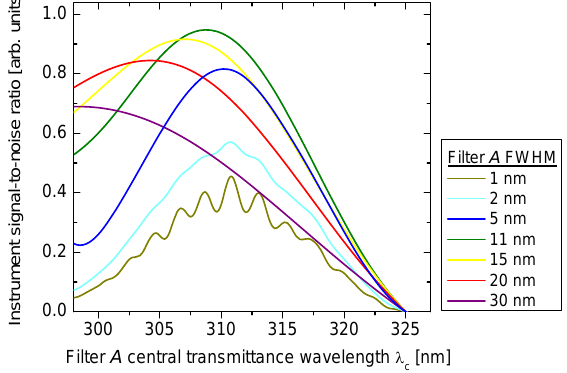
Figure 8. Modeled instrument signal to noise ratio as a function of the central wavelength of filter A (for typical conditions, see text). Different colors represent different transmittance window FWHM. A FWHM of less than about 2 nm is needed to resolve an individual SO 2 line. However, the signal-to-noise ratio increases for larger FWHM up to a width of 11 nm due to the increased light throughput. A further increase in the FHWM of the transmittance curve degrades the signal-to-noise ratio as wavelengths are included where either no scattered radiation is available or where SO 2 exhibits only weak absorption. A broad optimum is found for a bandwidth around 11 nm and a center wavelength λ c of about 309 nm.